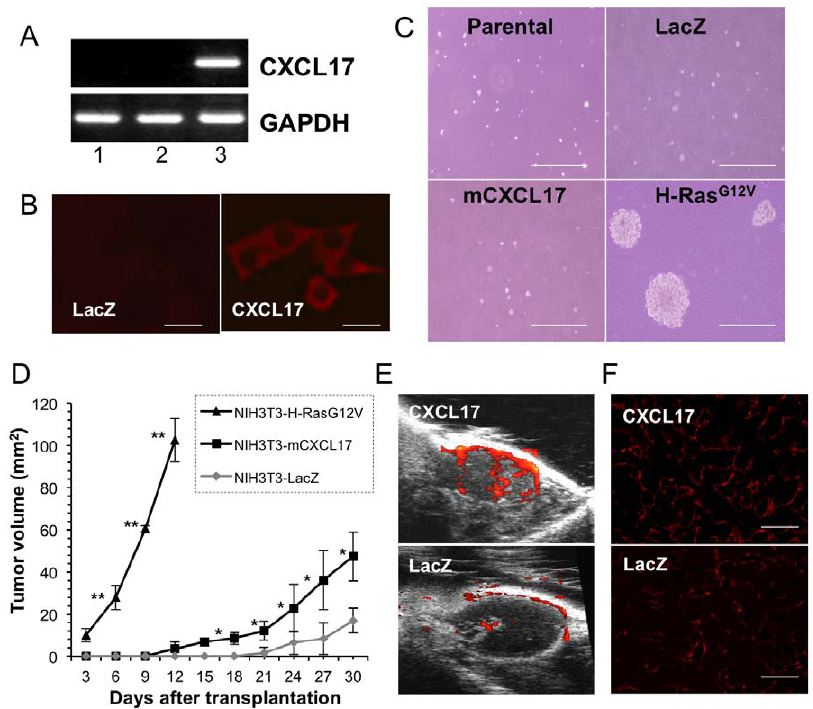
Figure 1. Tumorigenic potential of mouse CXCL17-expressing NIH3T3 cells. (A) Analysis of transduced mCXCL17 mRNA expression in NIH3T3 cells using RT-PCR. Upper panel, CXCL17; lower panel, GAPDH as an internal control. Lane 1, parental cells; lane 2, LacZ-transfected cells; lane 3, mCXCL17-transfected cells. (B) Immunostaining of CXCL17-expressing NIH3T3 cells probed with anti-mCXCL17 Ab. Left, LacZ-transfected cells; right, mCXCL17-transfected cells. Scale bar: 20 um. (C) Anchorage-independent growth assay. Representative phase-contrast microscopic images are shown. Scale bar: 100 um. (D) Transfected NIH3T3 cells (1 6 10 6 ) were transplanted into the subcutaneous space of CHO nude mice and tumor size was measured at the indicated time points. *, P=0.0154 (mCXCL17 versus LacZ); **, P , 0.0001 (mCXCL17 versus H-Ras V12 ); One of two independent experiments with similar results (n=3 2 4 per group). (E) Representative Doppler-based ultrasound real-time imaging of differential tumor blood flow. Upper, CXCL17 transfection; lower, LacZ transfection. (F) Immunostaining of tumor from NIH3T3 cells probed with anti-CD31 Ab. Upper, CXCL17- transfected cells; lower, LacZ-transfected cells. Scale bar: 100 um.